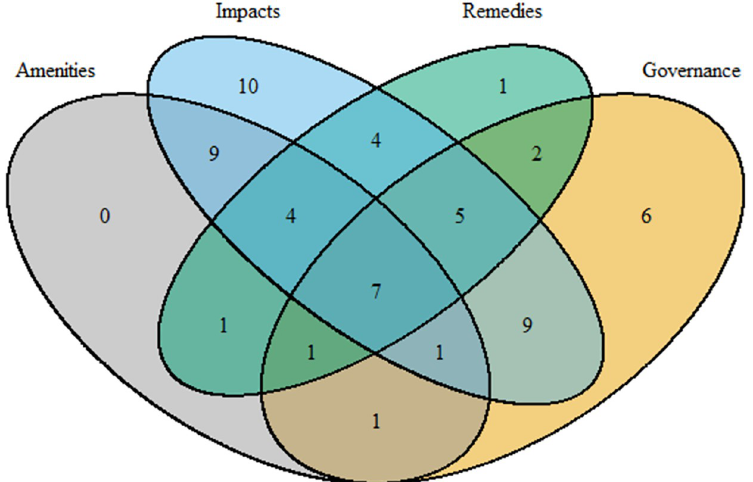
Fig 6. Venn diagram of number of papers for each of the four components in our definition of environmental justice.